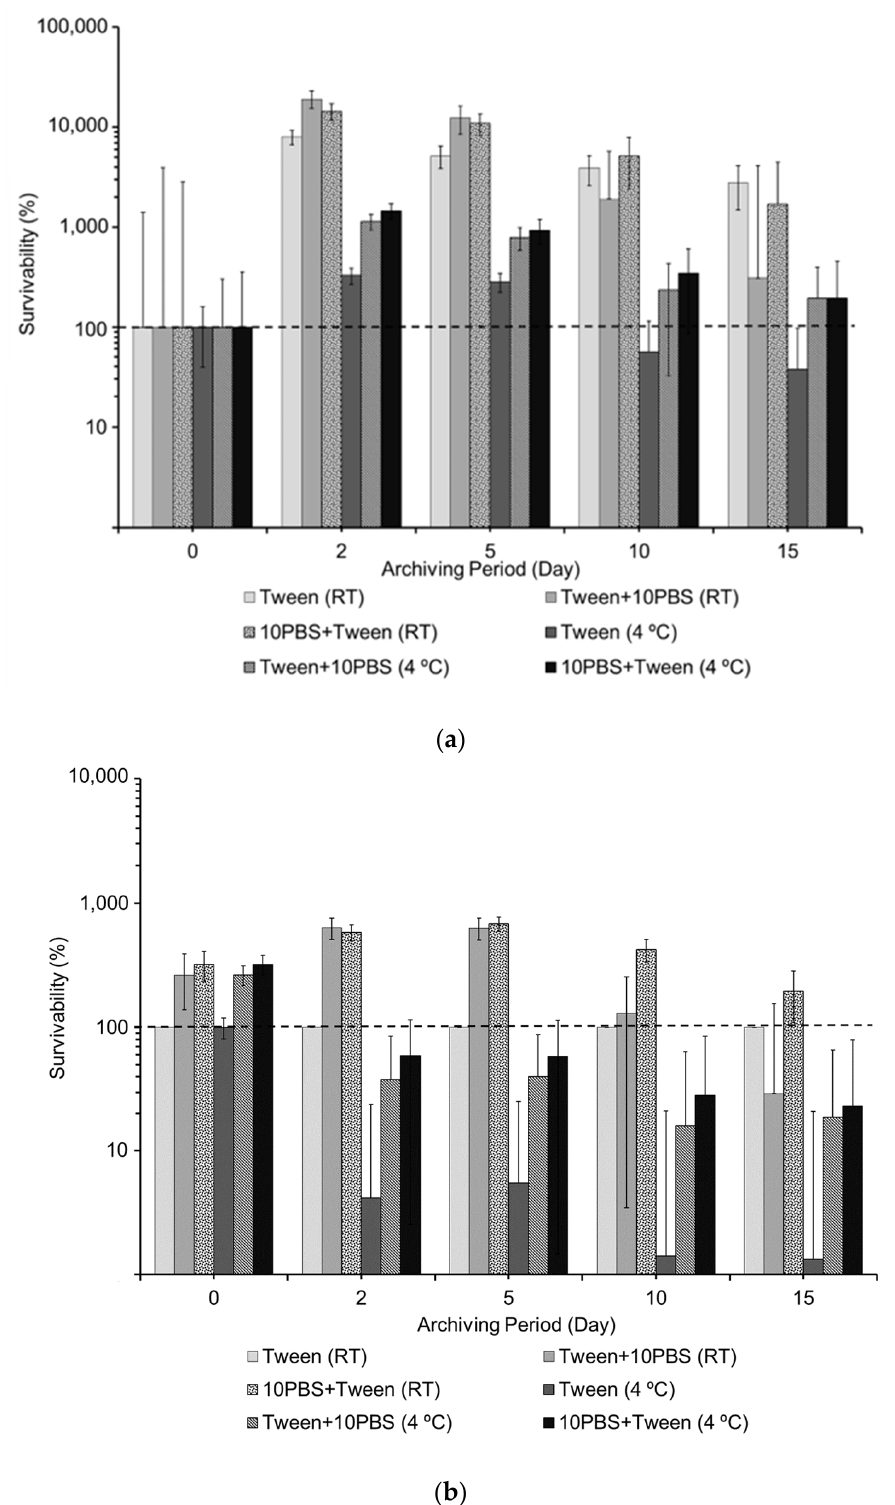
Figure 2. Survivability of the E. coli samples collected by the LCP-WWC at 55” H 2 O with the addition of PBS to 10% final concentration and archived at different temperatures for 10 days. ( a ). Values are compared to the CFU counts of the corresponding Day 0 samples as 100%. For example, Day 0 samples collected in Tween-20 and PBS were considered 100% and Day 2, 5, 20 and 15 samples collected in Tween-20 and PBS were compared to the same Day 0 sample ( b ). Values are compared to the CFU counts of each specific sample collected in Tween-20 and stored at RT as 100%.